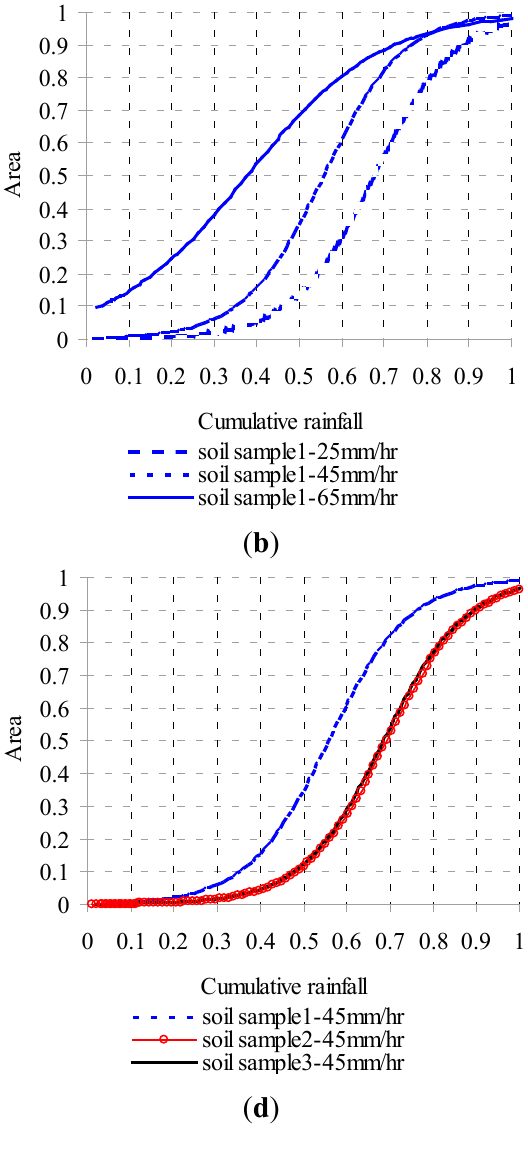
Figure 14. Dimensionless plots of soil erosion area: ( a ) Soil erosion under different rainfall intensity conditions; ( b ) soil erosion under different rainfall intensity conditions (fitting curve); ( c ) soil erosion under different material conditions; and ( d ) soil erosion under different material conditions (fitting